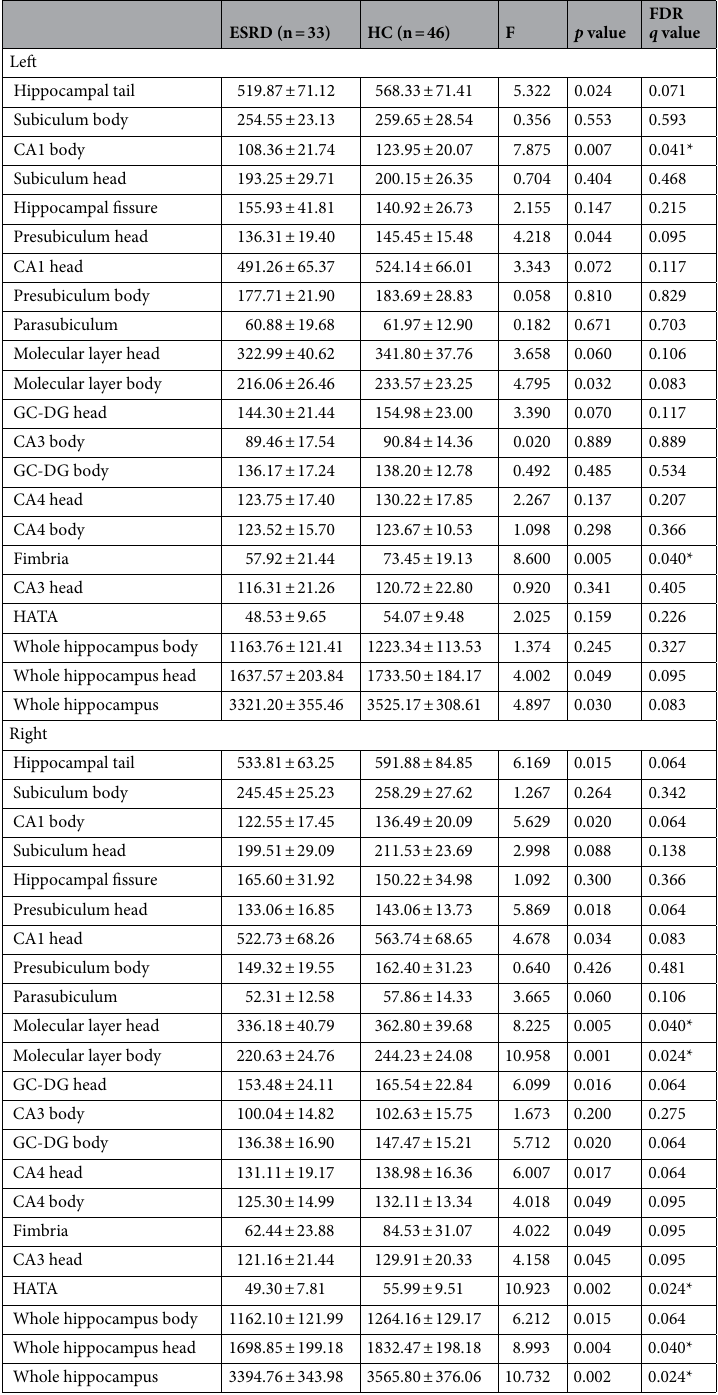
Table 3. Comparison of hippocampus and hippocampal subfields volumes (mm 3 ) between ESRD and